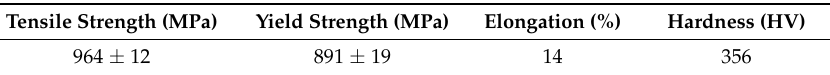
Table 2. Tensile properties and hardness of as-received Ti6Al4V alloy.